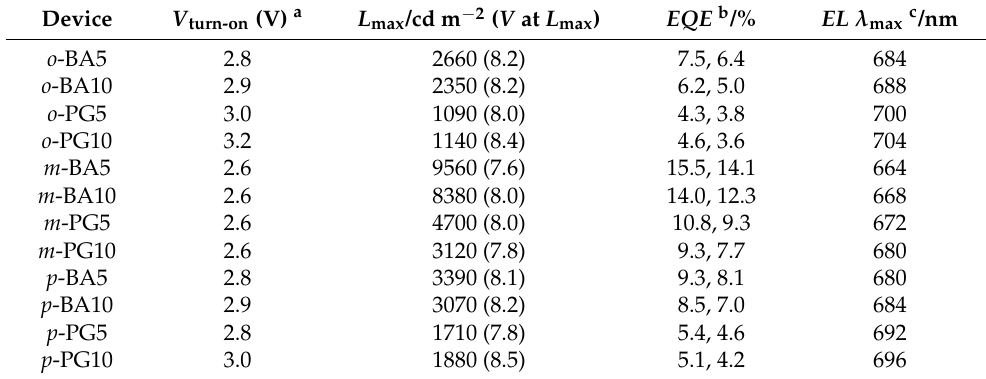
Table 3. Summary of the EL performance for all devices.